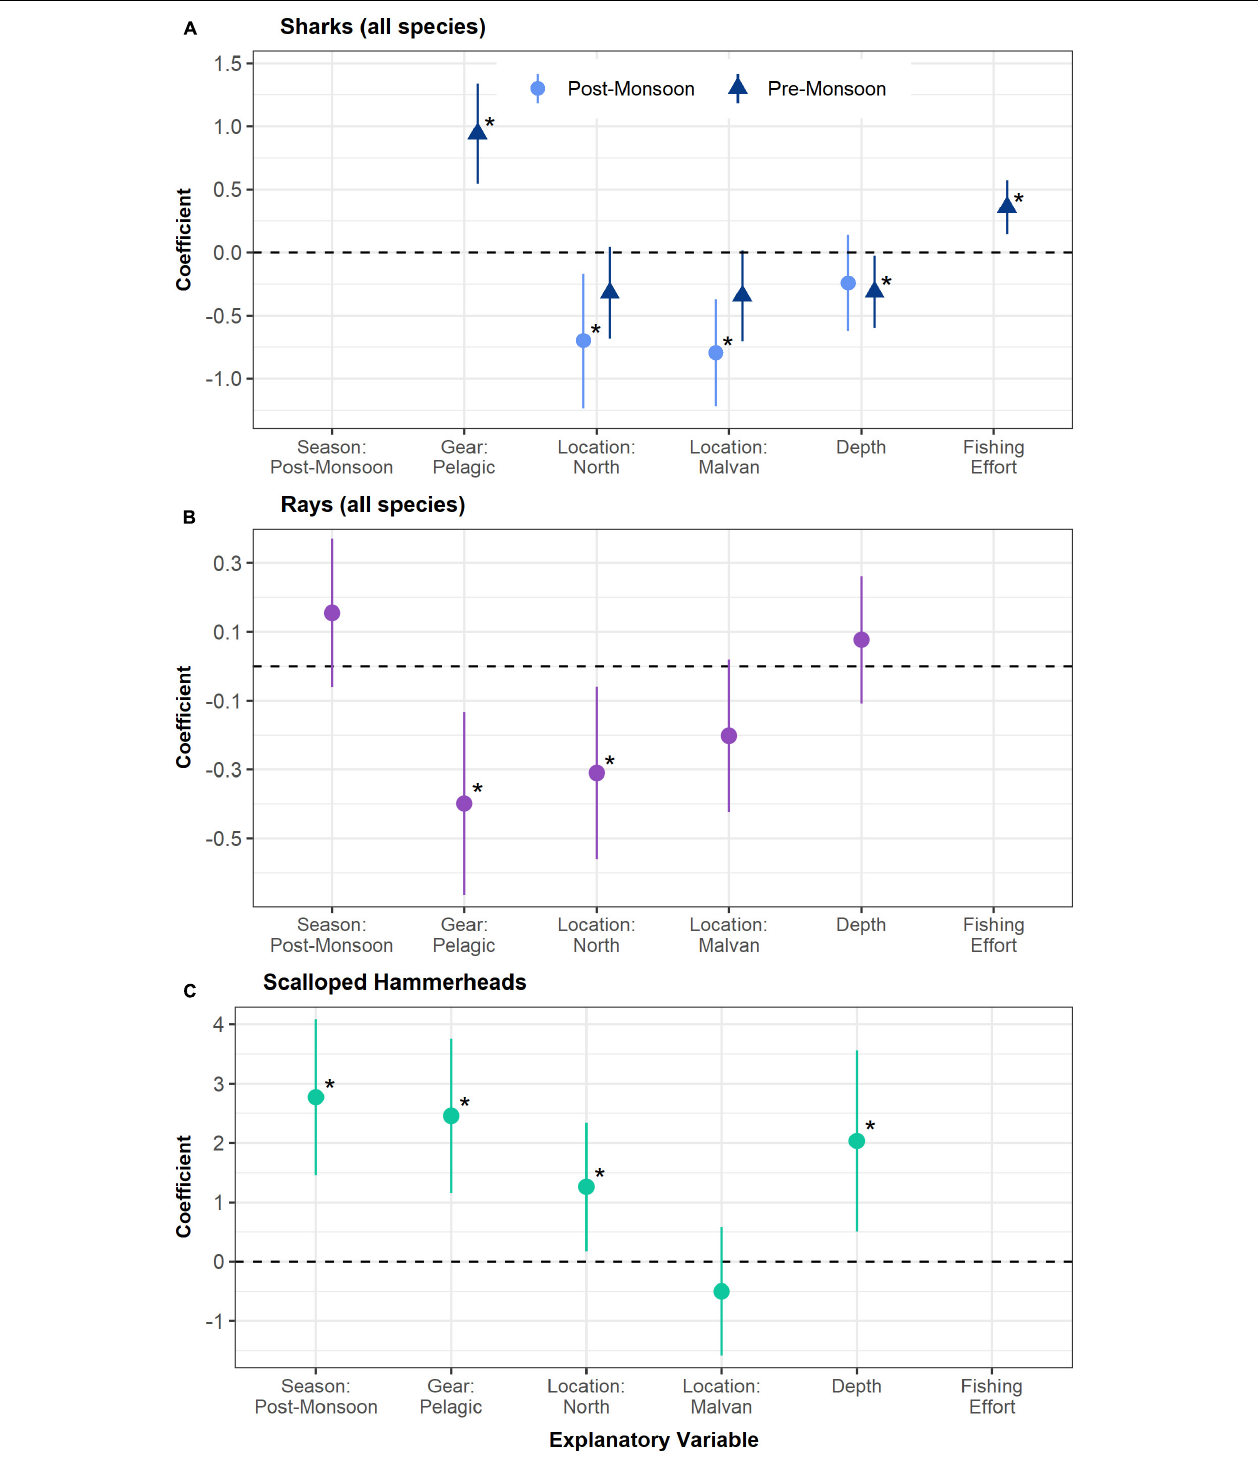
FIGURE 2 | Coefficients and confidence intervals of the best fit mixed models of the number of sharks captured (A) , number of rays captured (B) , and probability of hammerhead shark capture (C) plotted against various fishing variables. Panels (A,B) are lognormal models, whereas panel (C) is a binomial model. The coefficients of the categorical variables are given with respect to a reference category – for Location: South, for Gear: Benthic, for Season: Pre-monsoon, for Depth: Shallow. A positive coefficient for a category (for example, pelagic gear in panel (A) ) indicates a higher catch of that taxa as compared to the reference category (i.e., benthic gear). Similarly, positive coefficients of a continuous variable such as fishing effort indicate a higher catch at greater effort. Significant variables are indicated with an Asterix (*). Shark catches were modeled separately for the pre- and post-monsoon seasons.